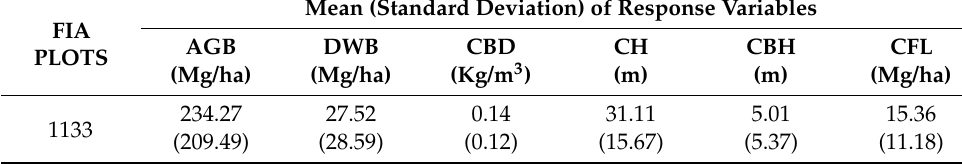
Table 3. ALS data acquisitions and summary of field